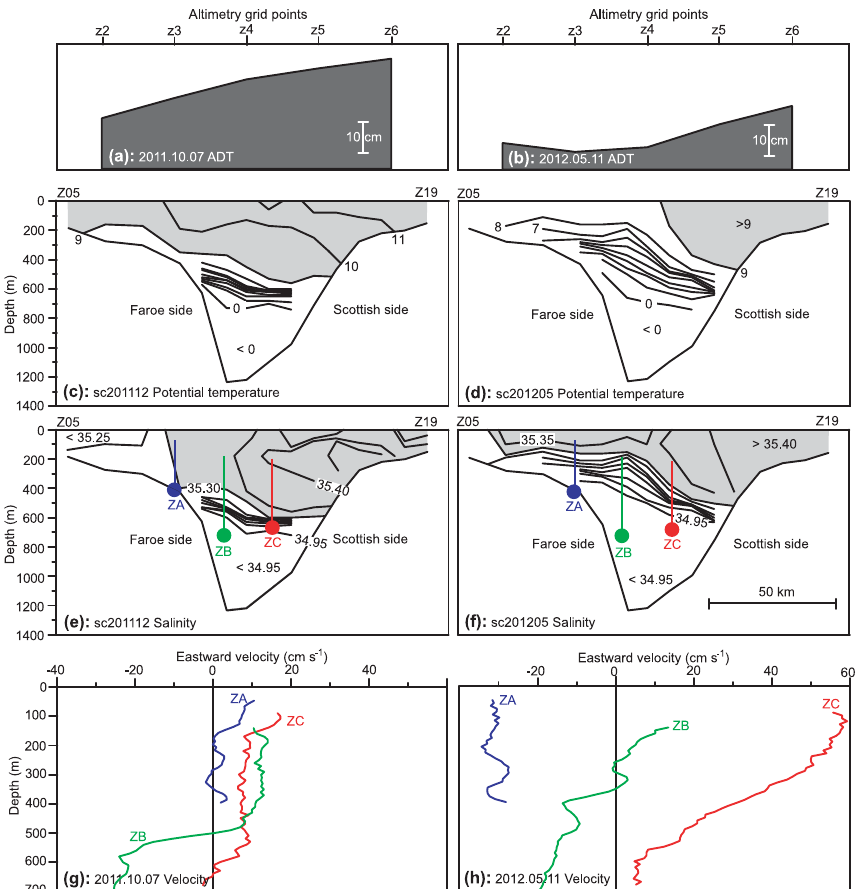
Figure 6. Conditions on the Z-section during two different cruises by MRV Scotia : cruise sc201112 on 7–8 October 2011 (a, c, e, g) , and cruise sc201205 on 10–12 May 2012 (b, d, f, h) . (a, b) Absolute dynamic topography (ADT). (c, d) Potential temperature distribution (in ◦ C, contouring interval: 1 ◦ C). Grey areas indicate water warmer than 9 ◦ C. (e, f) Salinity distribution (contouring interval: 0.05). Grey areas indicate water more saline than 35.30. (g, h) Eastward component of ADCP velocity profiles (ADCP locations indicated in panels e and f ). Panels (a) , (b) , (g) , and (h) are for dates in the middle of each cruise but would not look significantly different for other days within the cruise